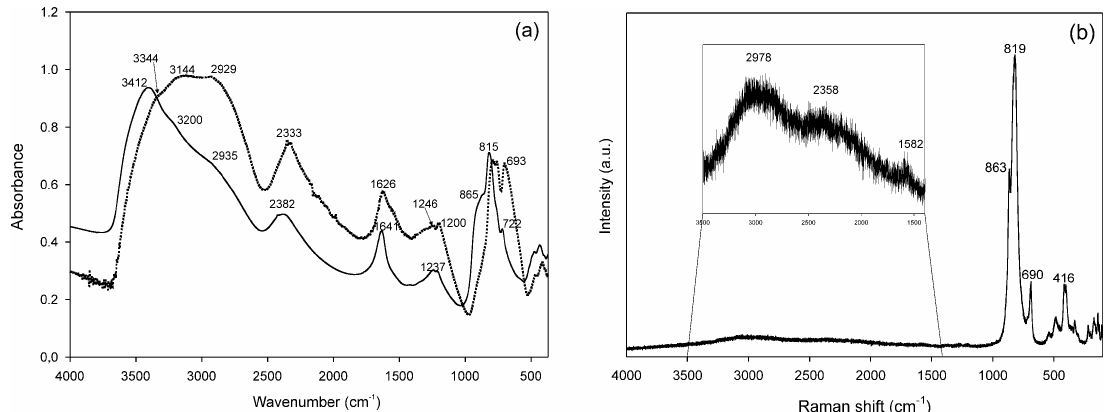
Figure 3. ( a ) Infrared spectra of CoAsAllu (full-line – powder spectrum; dotted line: ATR-spectrum) and ( b ) single-crystal Raman spectrum of CoAsAllu.